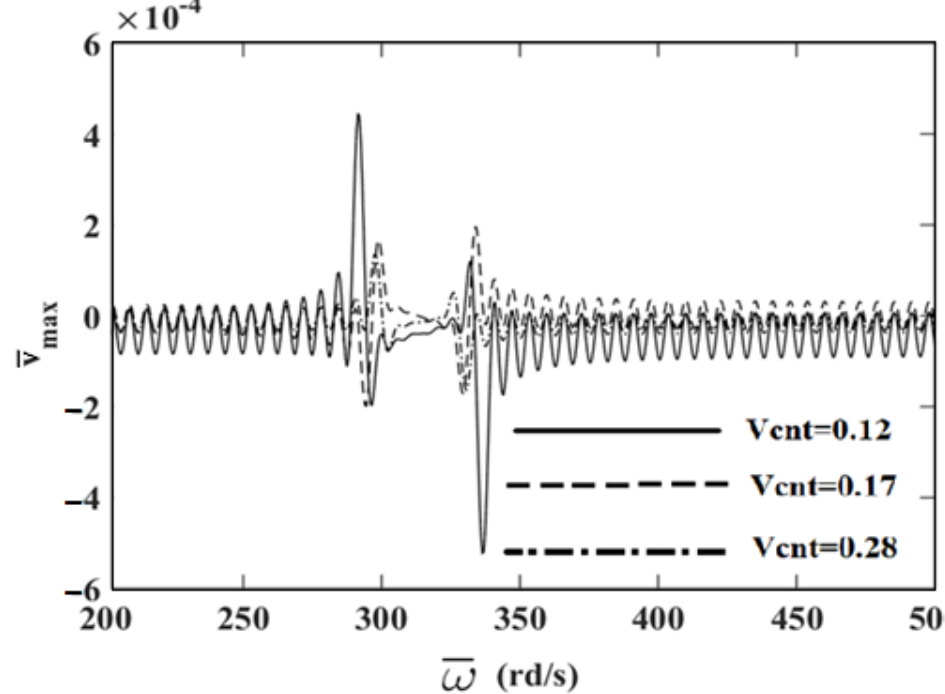
Figure 8. The relationship between the displacements and the frequency of the dynamic load ( 𝑤̅ ) in the simply supported uniformly distributed (UD)-beam for different values of V CNT .